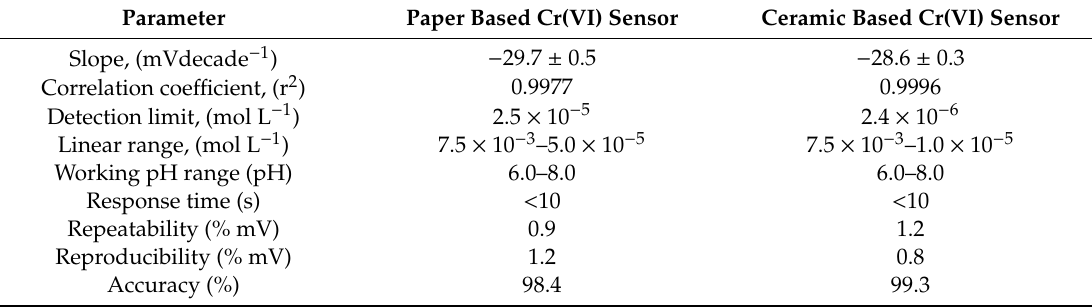
Table 1. Potentiometric response characteristics of paper and ceramic based chromium(VI)